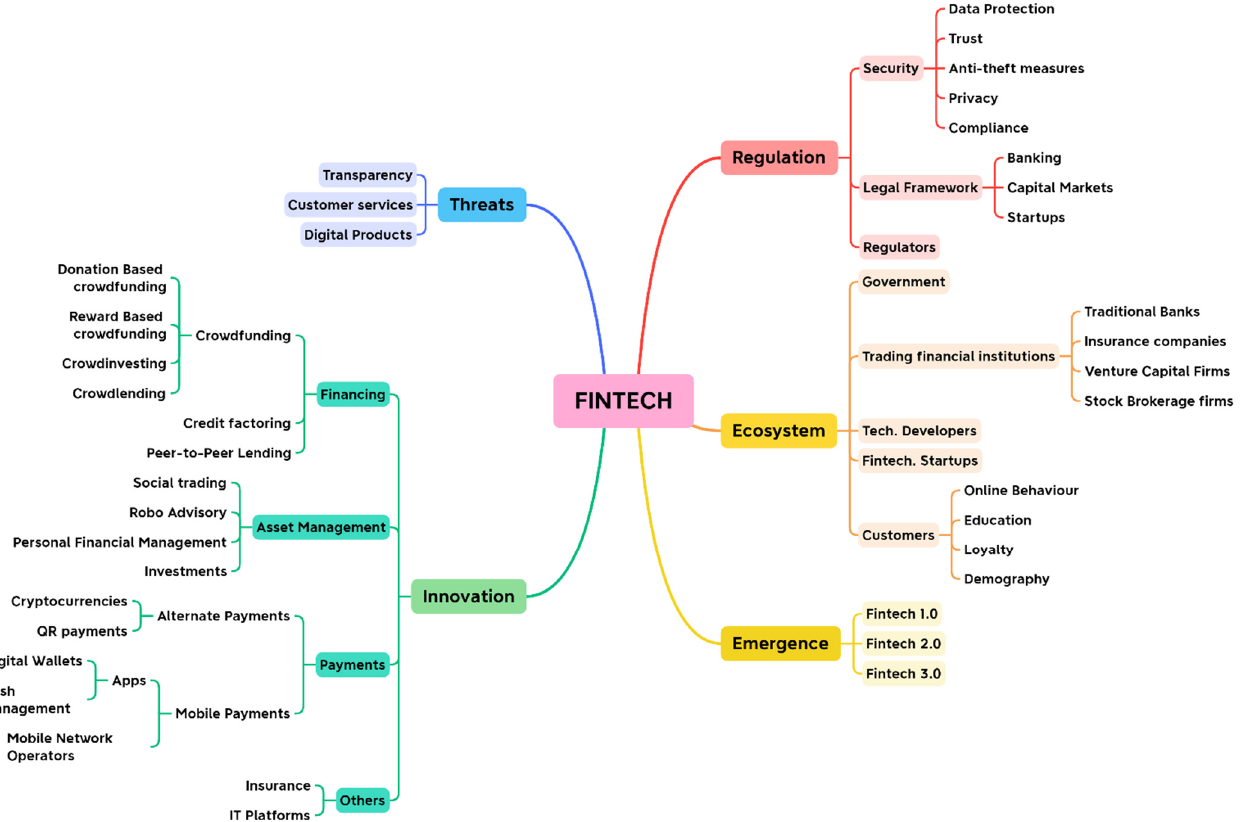
Figure 5. Mind map of fintech built on systematic literature review. Source: Researchers’ own source.